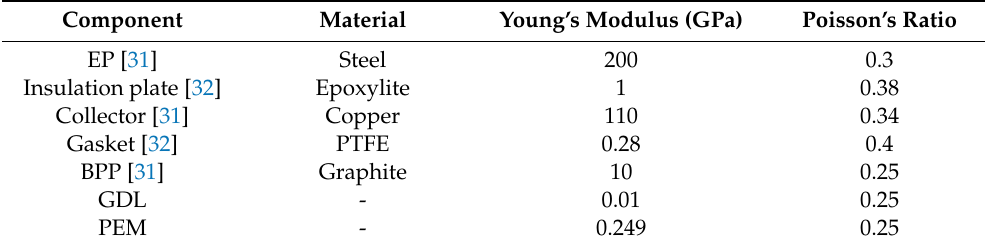
Table 1. Material properties used in the FE model.